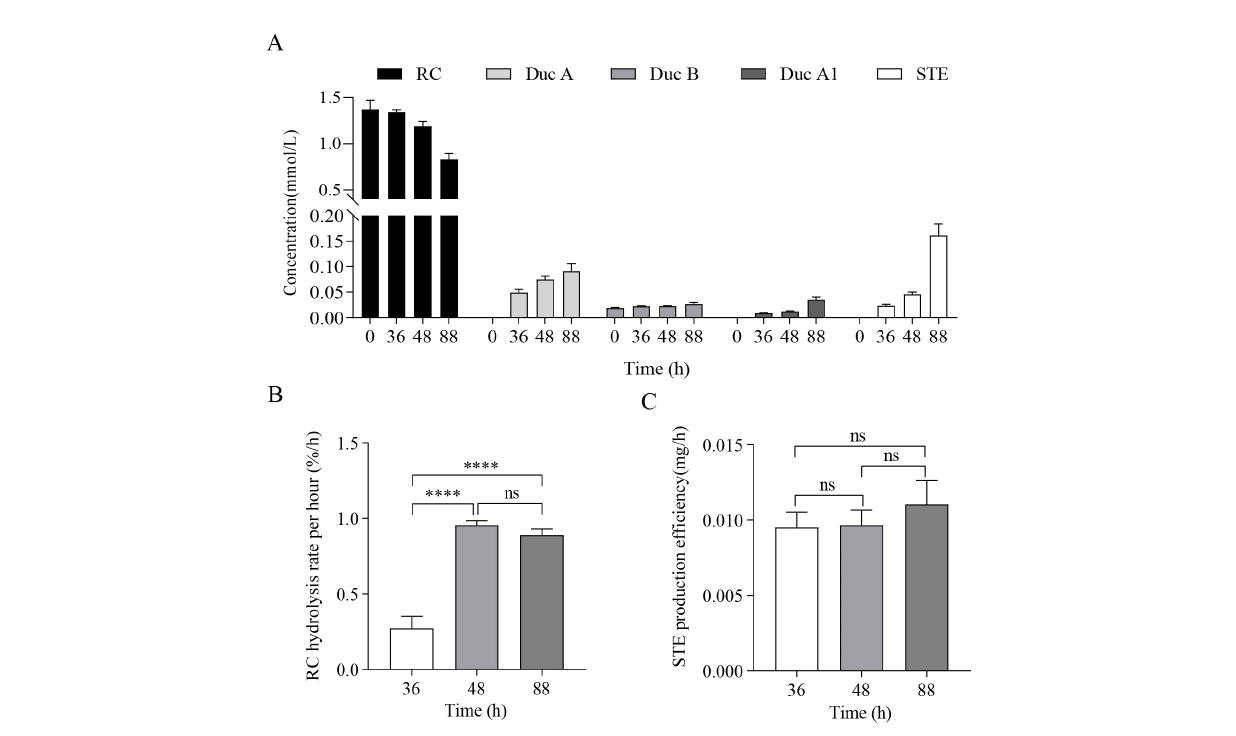
FIGURE 1 RC fermentation by Paenarthrobacter ilicis CR5301. (A) Concentration changes in RC and metabolites in the samples from the treatment groups at different times, (B) RC hydrolysis rate per hour at different times, and (C) STE production efficiency at different times. [ **** p < 0.0001, NS: not significant ( p >